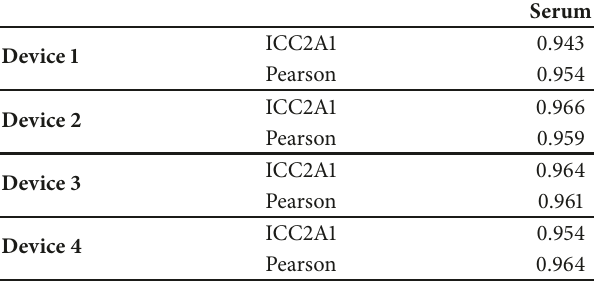
Table 2: Correlation between BiliCare (cid:2) and serum bilirubin.